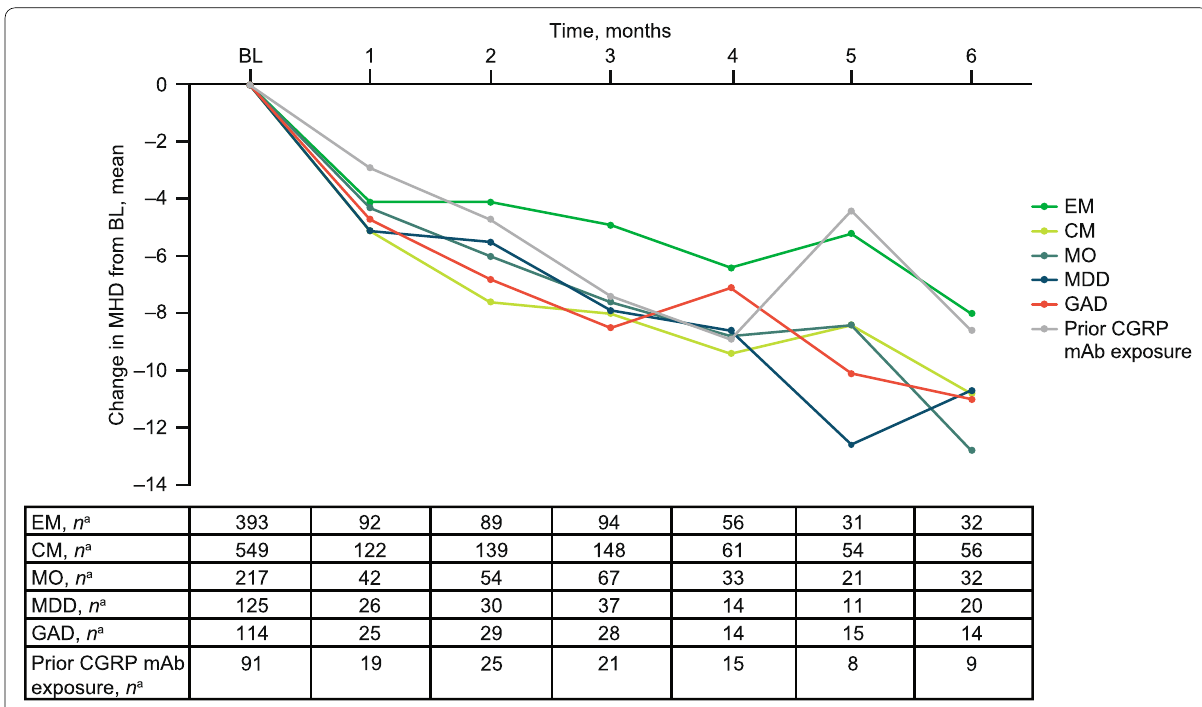
Fig. 4 Change from baseline in MHD across patient subgroups. BL, baseline; CGRP, calcitonin gene‑related peptide; CM, chronic migraine; EM, episodic migraine; GAD, generalized anxiety disorder; mAb, monoclonal antibody; MDD, major depressive disorder; MHD, monthly headache days; MO, medication overuse. a Number of patients with available assessment at each time